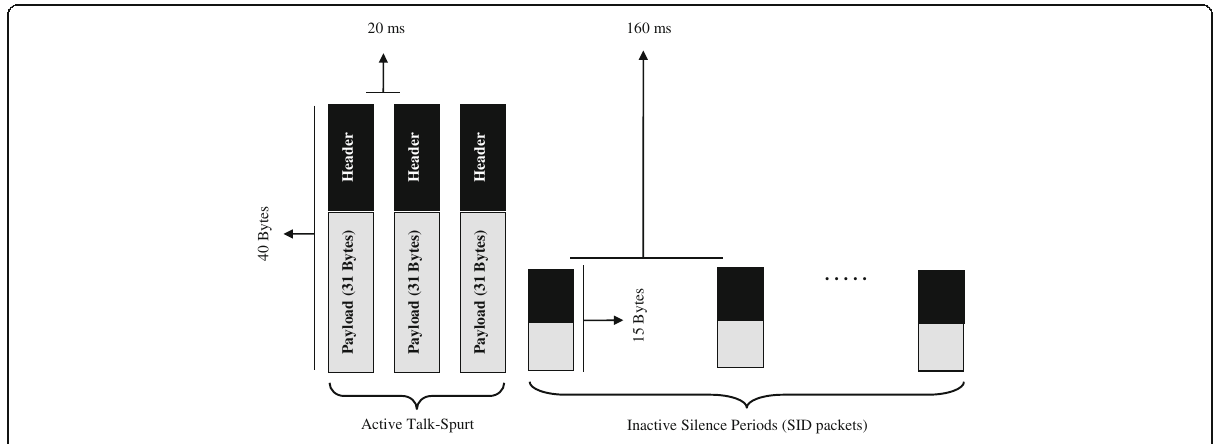
Fig. 4 Illustration of active and inactive periods for voice traffic